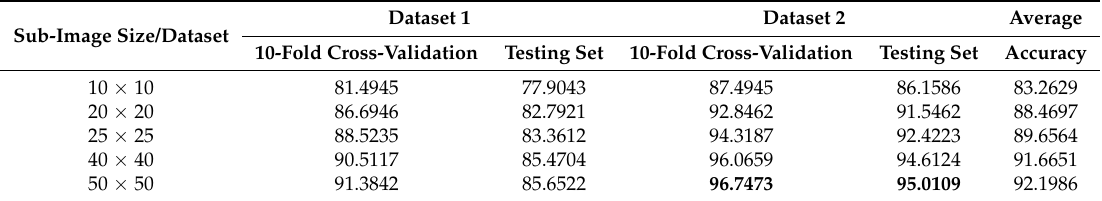
Table 5. Performance of the K-nearest neighbors algorithm, K =